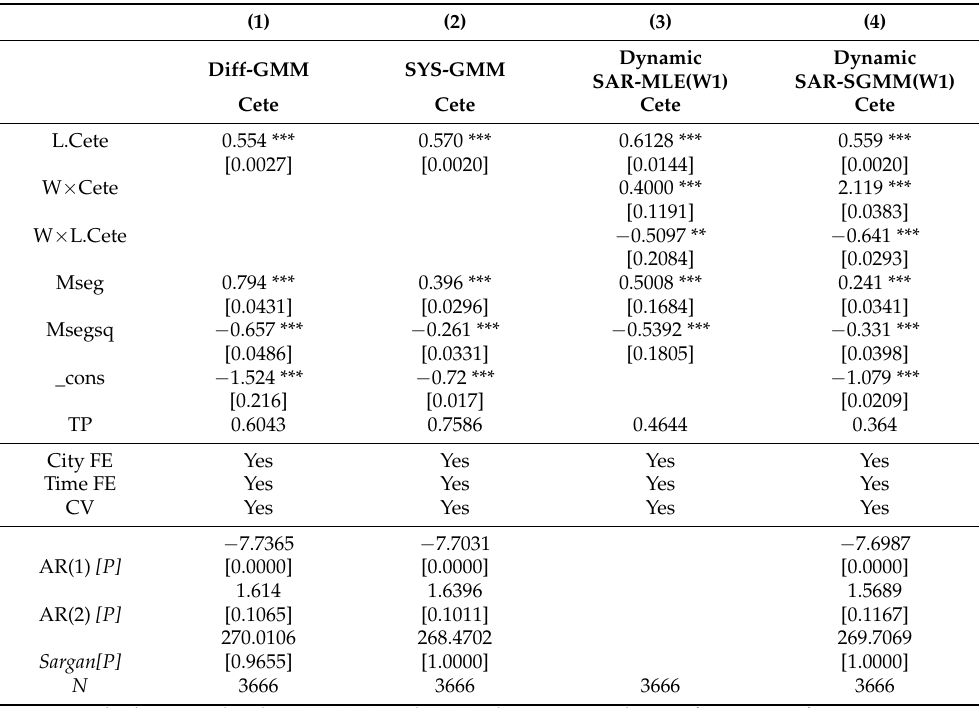
Table 5. Regression results of dynamic panel and dynamic spatial panel